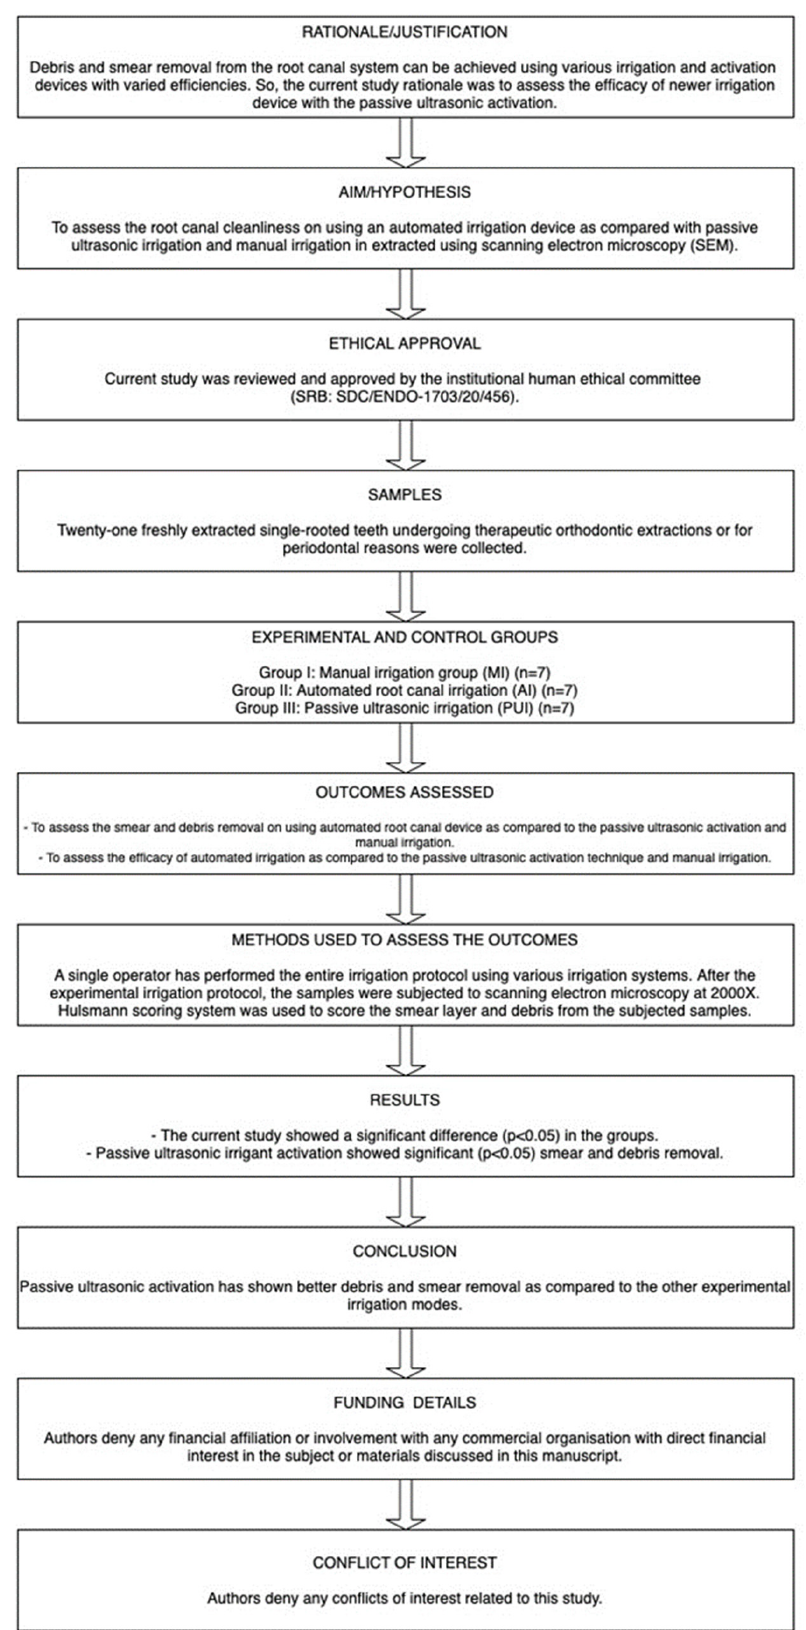
Figure 1. PRILE 2021 flow chart . Twenty-one freshly extracted single-rooted teeth were collected. The inclusion criteria for the specific teeth were curvatures < 5 degrees, fully matured apex, patent root